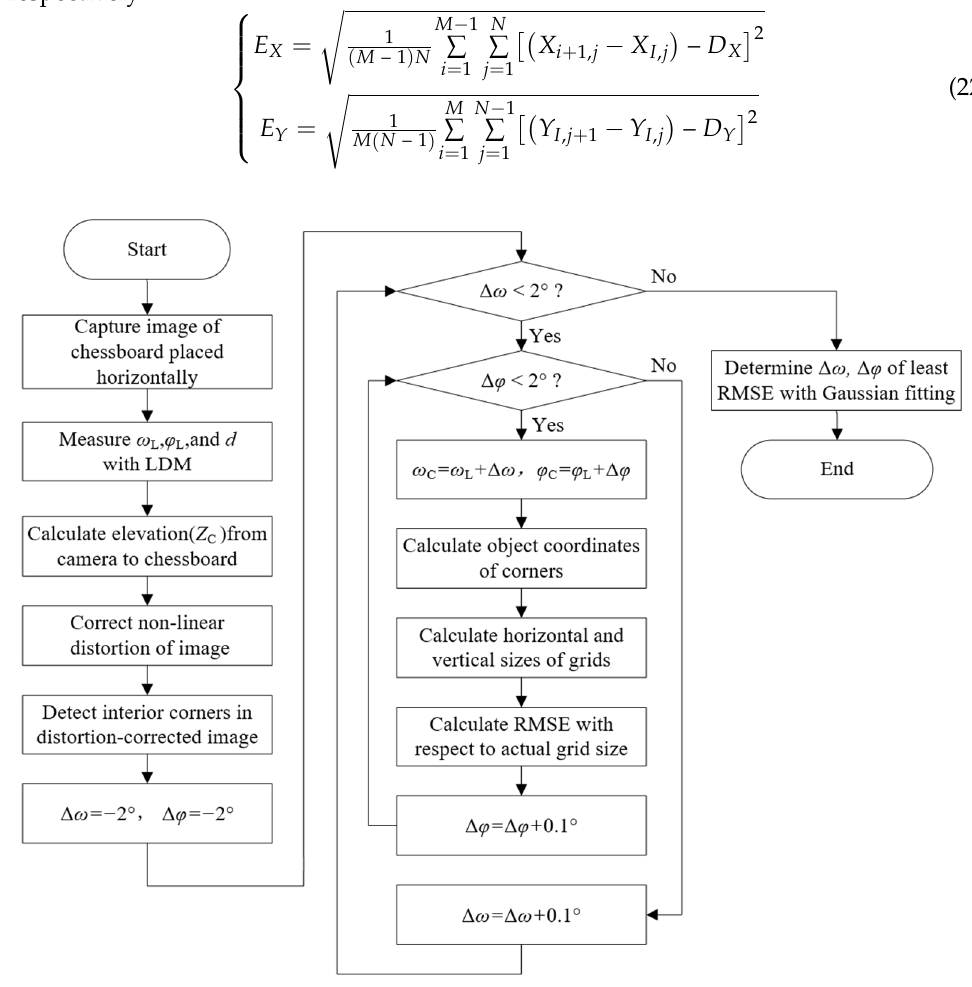
Figure 6. Flow chart of eccentric angles calibration.